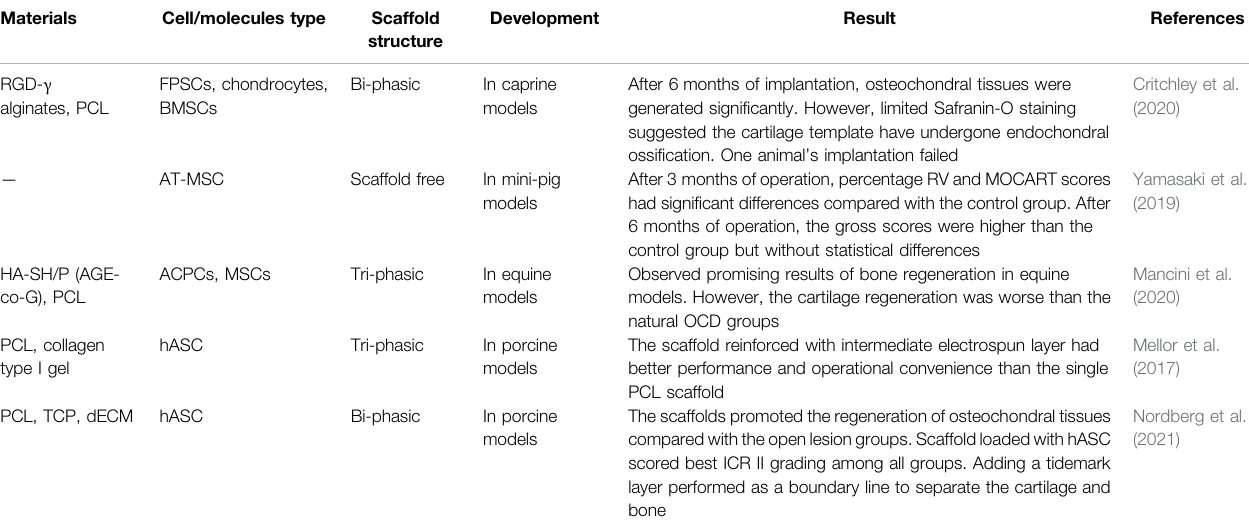
TABLE 1 | Current clinical translational results of 3D printing for OCD regeneration in big animal